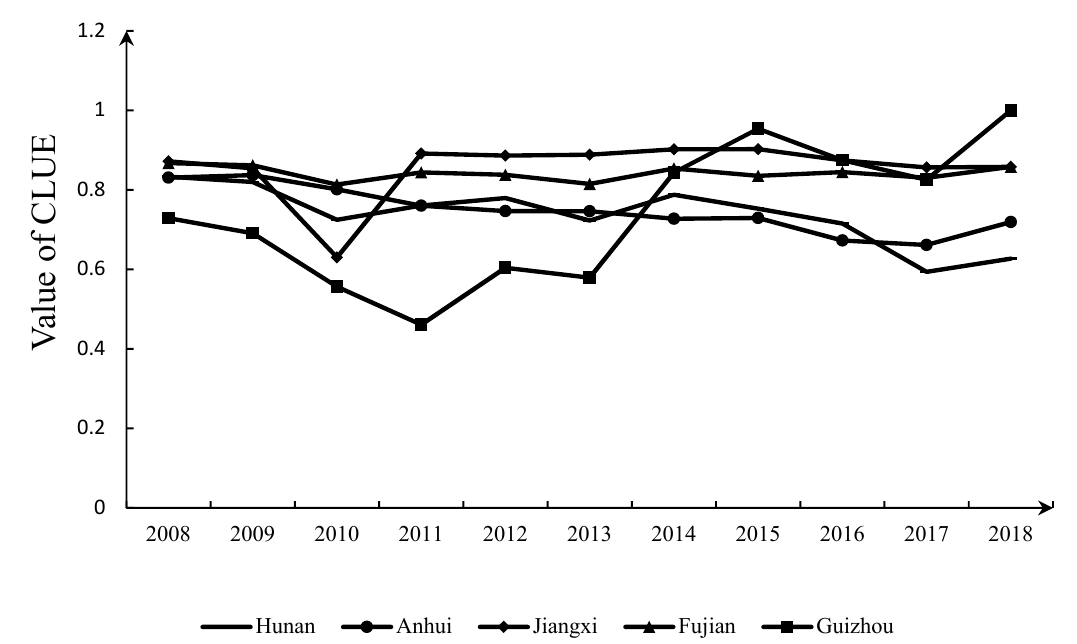
Figure 2. Change trend of the CLUE in the study region from 2008 to 2018.